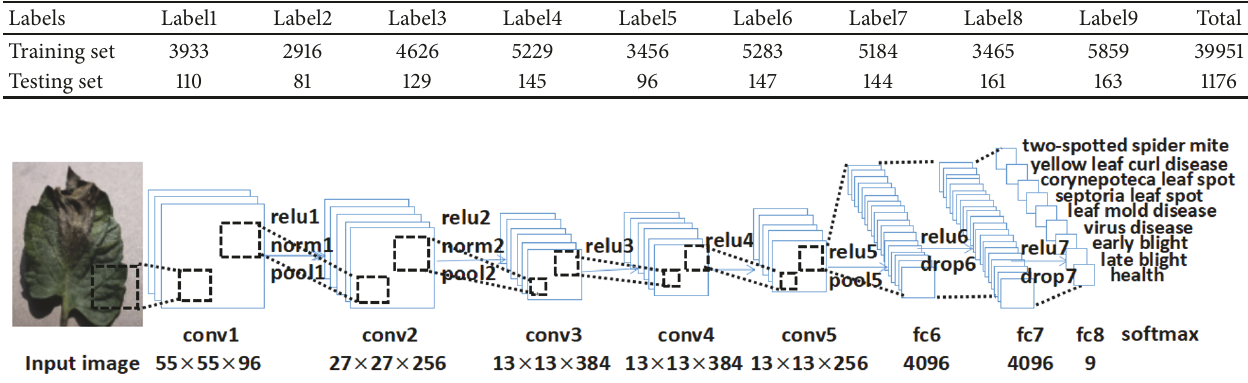
Figure 3: The architecture of AlexNet in this